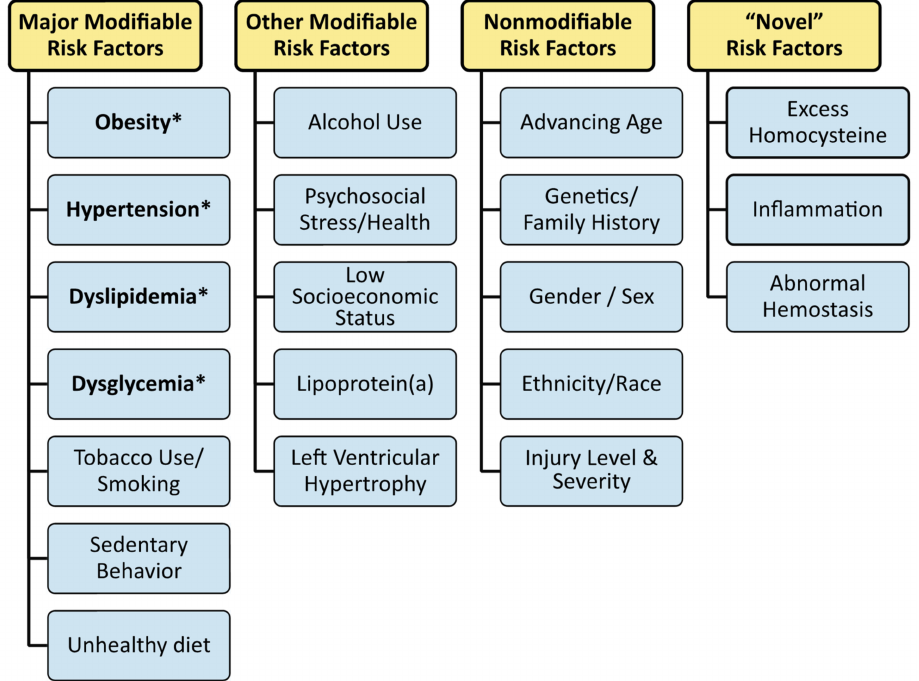
Figure 2. Modifiable and nonmodifiable risk factors for cardiometabolic risk. Component risk factors for cardiometabolic syndrome are marked with an asterisk